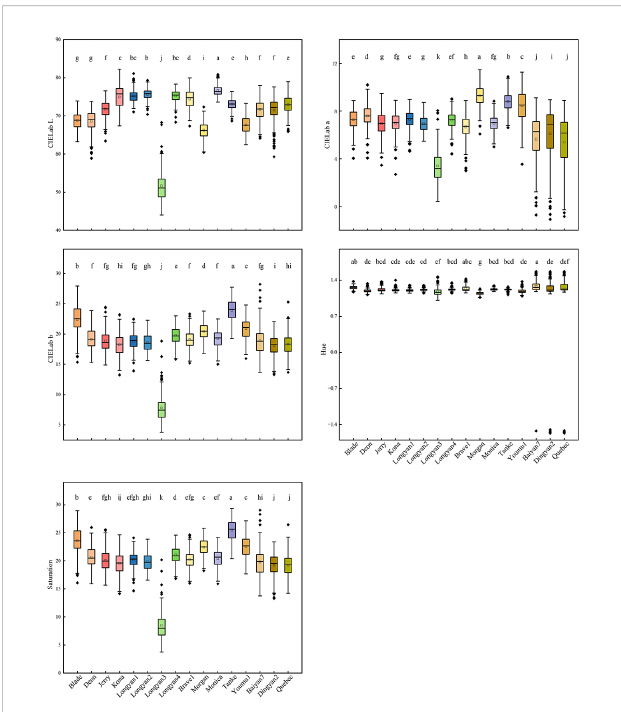
FIGURE 3 CIELab L*a*b*, saturation and hue features of 16 Avena sativa L. cultivars. Different lowercase letters represent signi fi cant differences between cultivars with the same feature